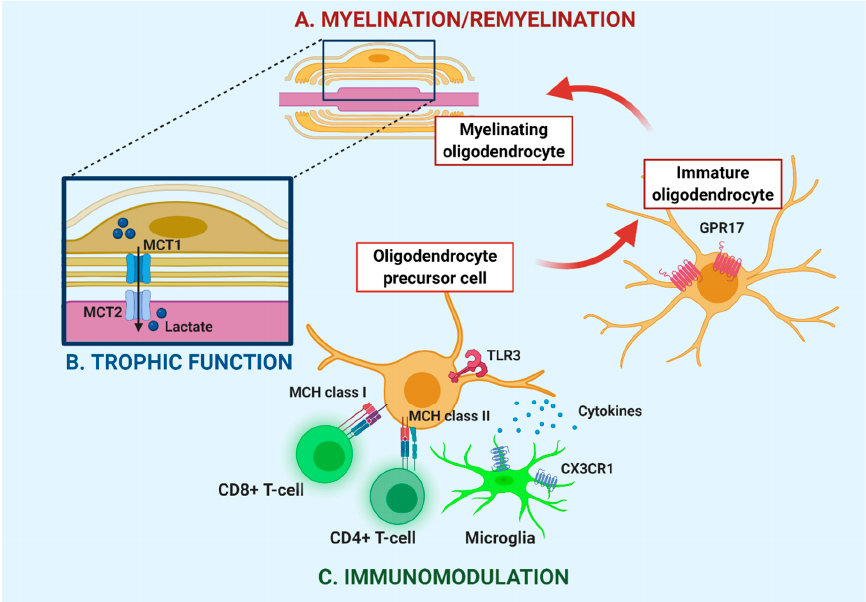
Figure 1. Functions of oligodendrocyte (OL) lineage cells in the adult central nervous system (CNS). Oligodendrocyte precursor cells (OPCs) become mature and sustain myelination and remyelination during development or in response to injury ( A ). Mature myelinating OLs release lactate produced by glycolysis into the periaxonal space through monocarboxylate transporter (MCT) 1. Neurons can in turn take up lactate through the MCT2 to support mitochondrial ATP synthesis ( B ). Finally, OPCs in the disease state are also known to express major histocompatibility complex (MHC) class I and II and several cytokines which enable them to modulate T-cells and microglia, thus affecting the immune response ( C